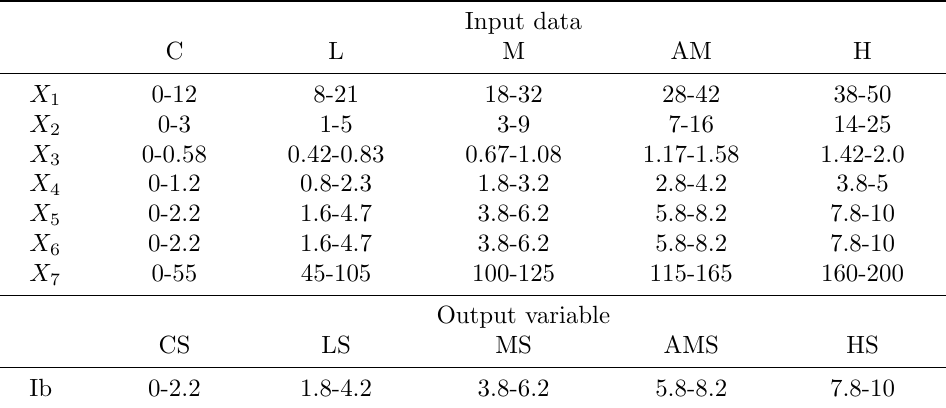
Table 5: Limits of terms for linguistic variables